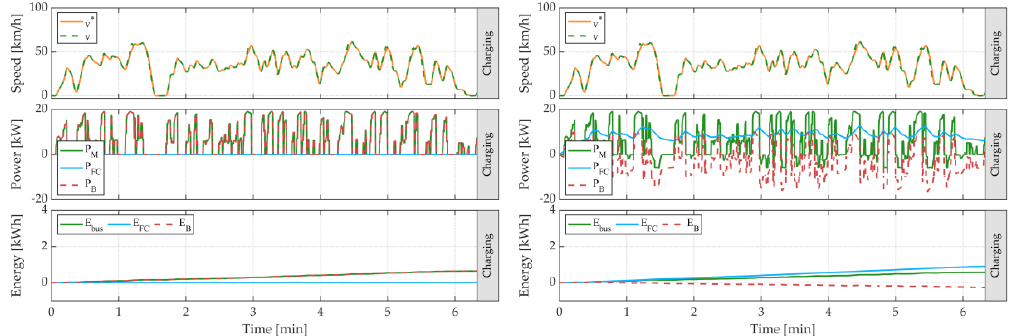
Figure 19. Powers and energies achieved over REAL by H-EMS ( left ) and S-EMS ( right ).